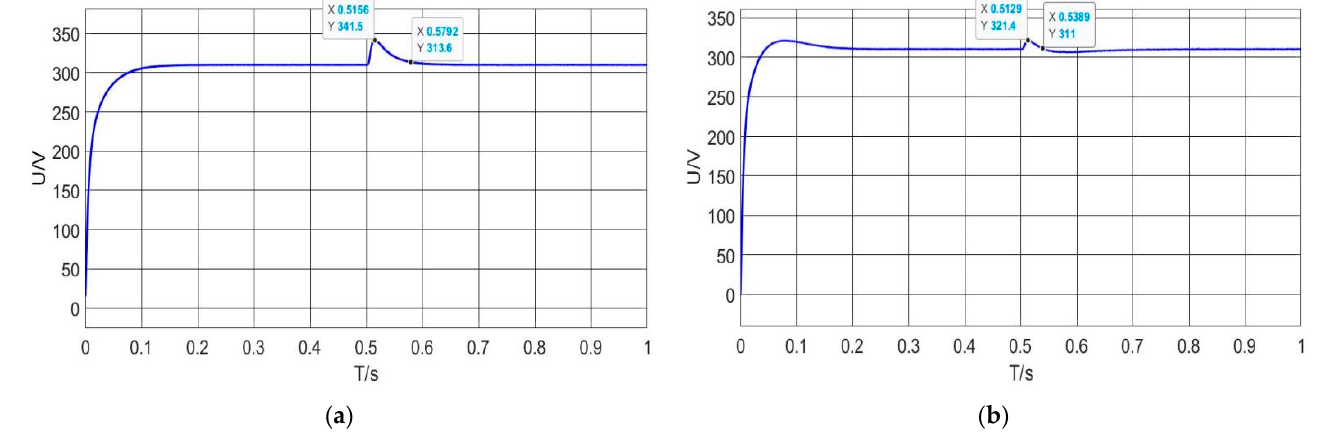
Figure 14. Critical load voltage curve. ( a ) With v/F control. ( b ) With electric spring control.